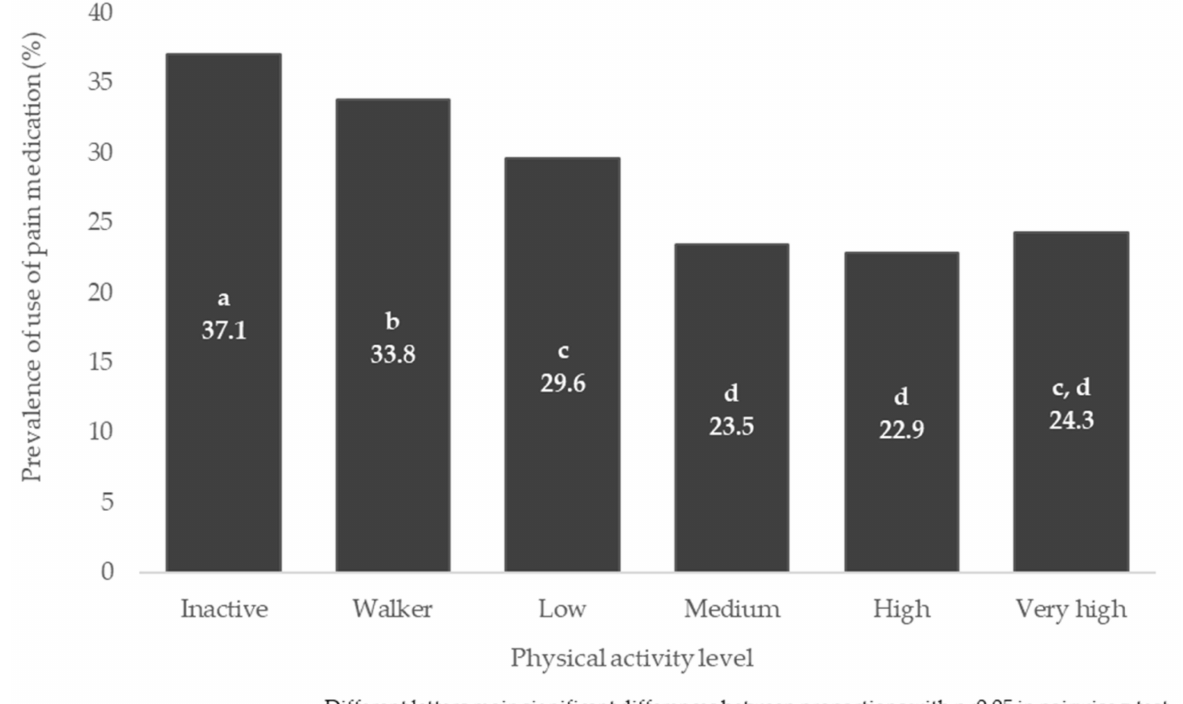
Figure 3. Prevalence of use of pain medication in the general population, according to physical activity